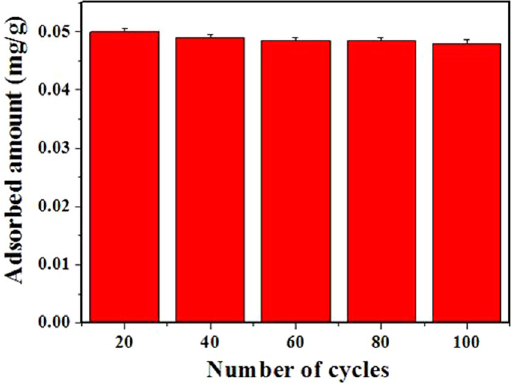
Figure 8. Variation of 4-nonylphenol adsorption on recycled ZIF-8/PEG-NH 2